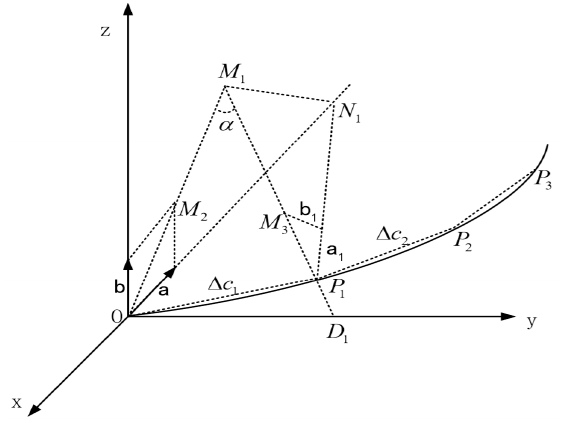
Figure 9. Schematic diagram of space curve fitting.